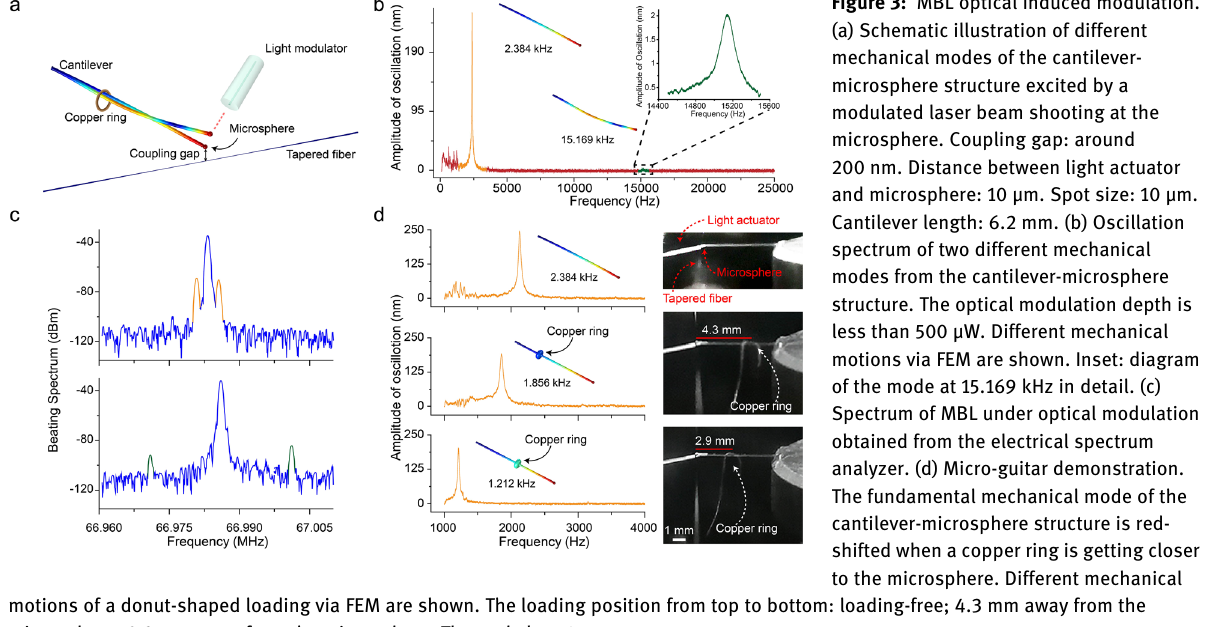
Figure 3: MBL optical induced